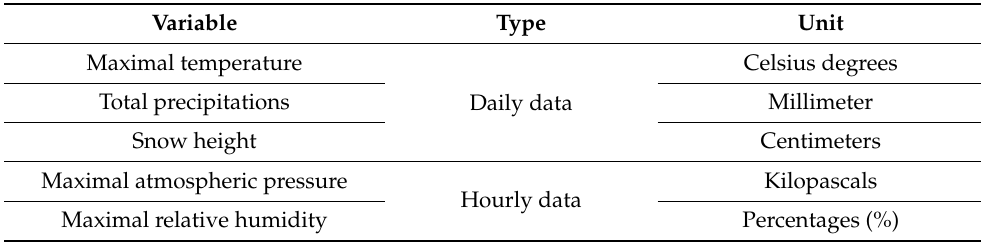
Table 3. Meteorological variables